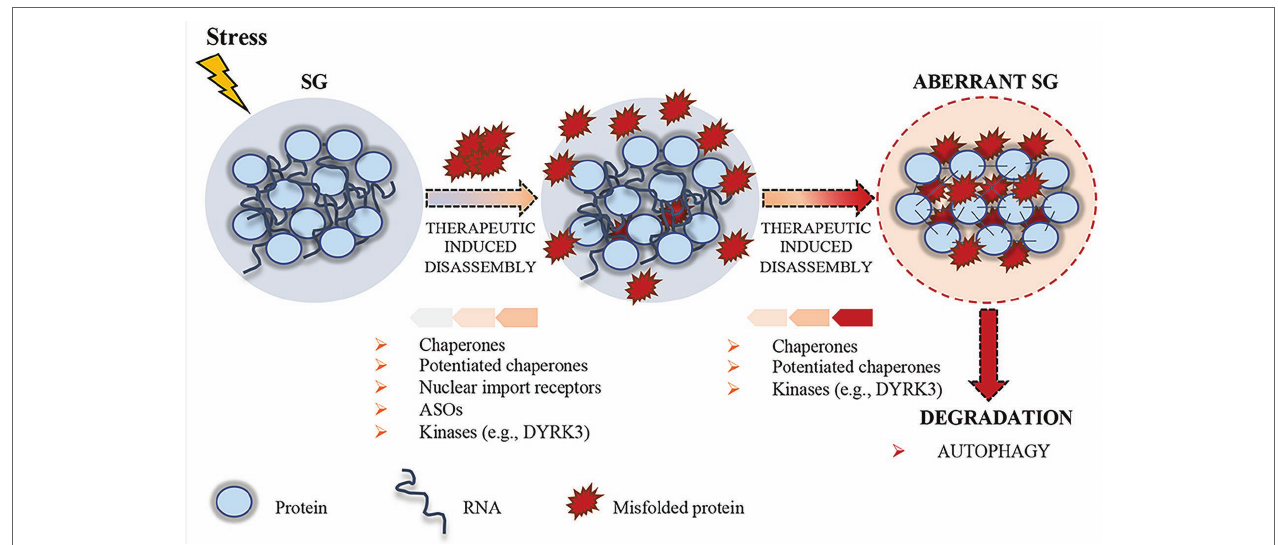
FIGURE 3 | Schematic representation of stress granule (SG) dynamics. Upon stress condition, SGs assemble; RNA and proteins accumulate in these granules until the stress persists. After removal of the stress condition, SGs disassemble, protein synthesis is reactivated after the translation inhibition induced by the stress, and RBPs can either go back to the nucleus or remain in the cytoplasm, where they carry out their normal functions. Misfolded proteins can accumulate in SGs, thus altering their physical properties. To prevent the accumulation of misfolded proteins, therapeutic strategies, such as chaperones, potentiated chaperones, protein kinases (e.g., DYRK3), nuclear import receptors, and ASOs, can be engineered to induce SG disassembly. If the disassembly does not occur, SGs become aberrant and can promote the pathogenesis of neurodegenerative disorders. Finally, aberrant SGs can undergo disassembly by chaperones, potentiated chaperones, or kinases, and, if not repaired, they undergo degradation by